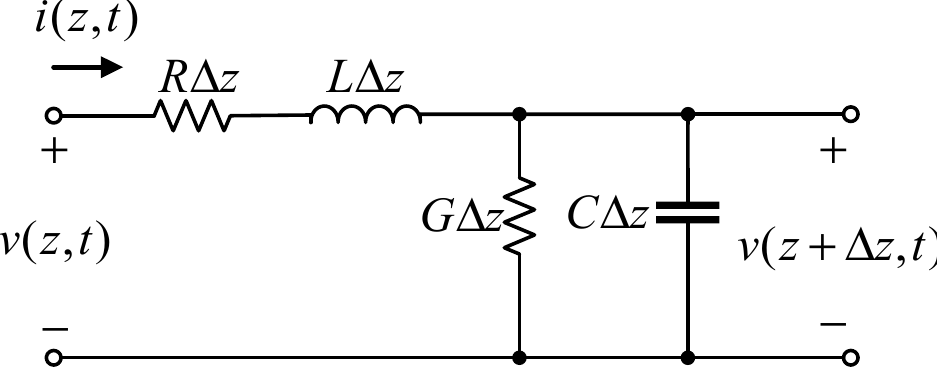
Figure 7. Schematic diagram of transmission line equivalent circuit.